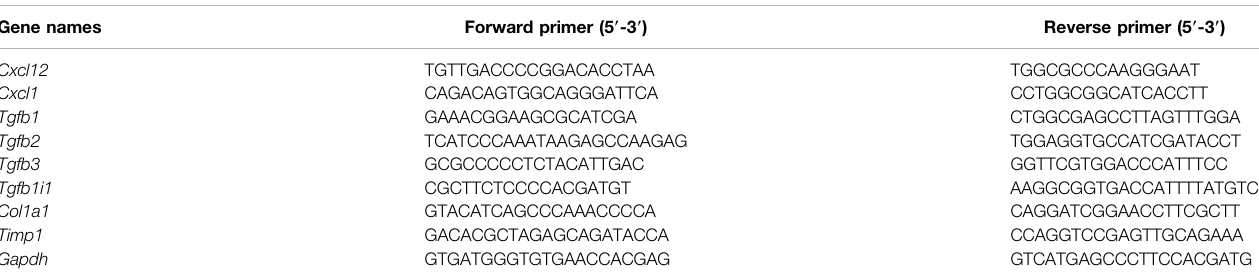
TABLE 2 | mRNA primer